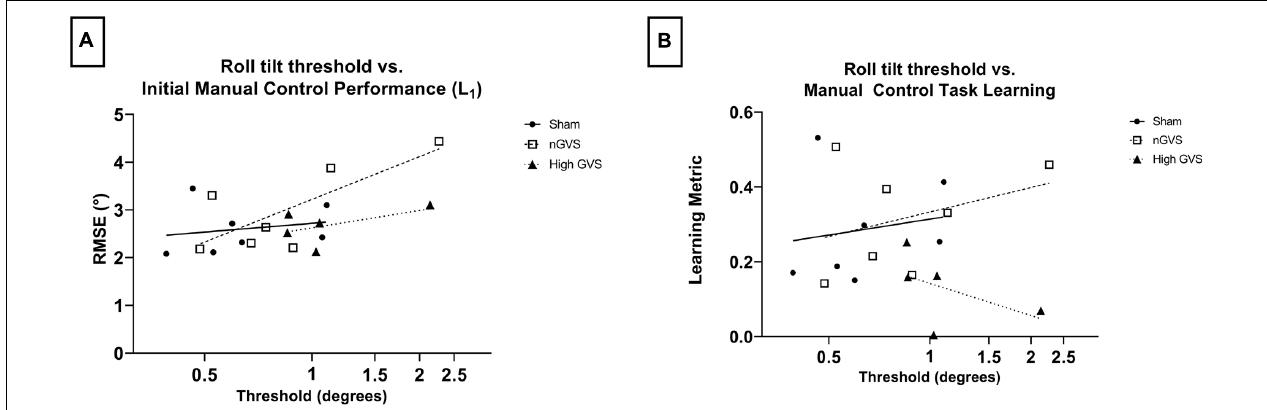
FIGURE 5 | Correlating DR threshold and task performance for manual control subjects. (A) While all subjects show a positive correlation between DR threshold and initial task performance, this relationship is only significant for nGVS subjects ( p = 0.05). (B) No significant correlation between DR threshold and manual control task learning across any treatment